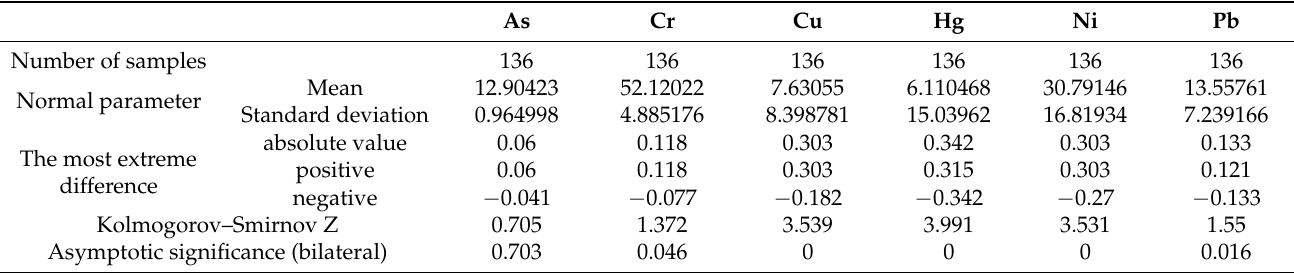
Table 7. Single-sample Kolmogorov–Smirnov